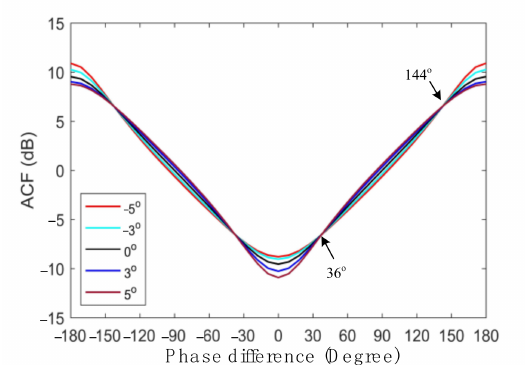
Figure 9. Slopes of ACFs versus different deviation of ∆ θ = 0 ◦ , ± 3 ◦ , ± 5 ◦